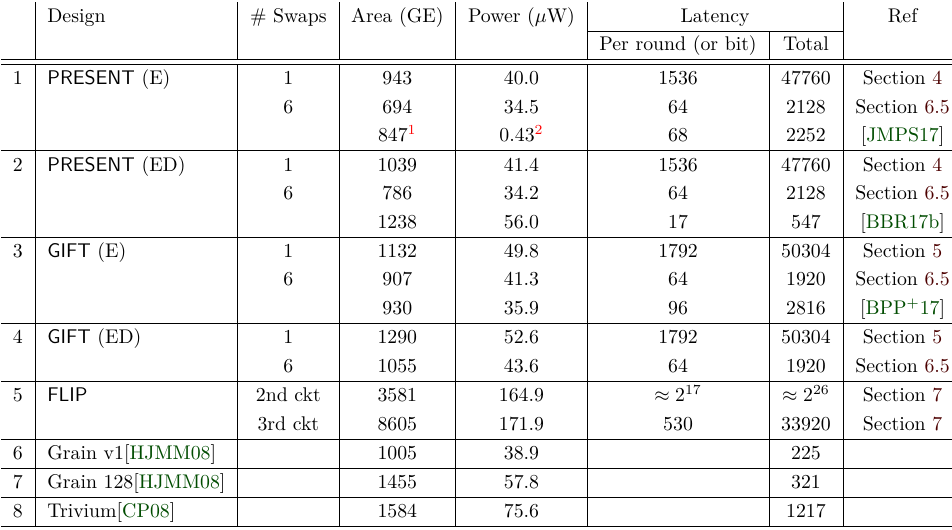
Table 1: Tabulation of Results (unless stated otherwise, power reported at 10 MHz. Total latency refers to number of cycles required to encrypt one block of 64 bits. For completeness, comparison with the most lightweight circuits of a few eStream finalist candidates is also included) 1 : Synthesized using IBM 130nm CMOS process, 2 : Power reported at 100